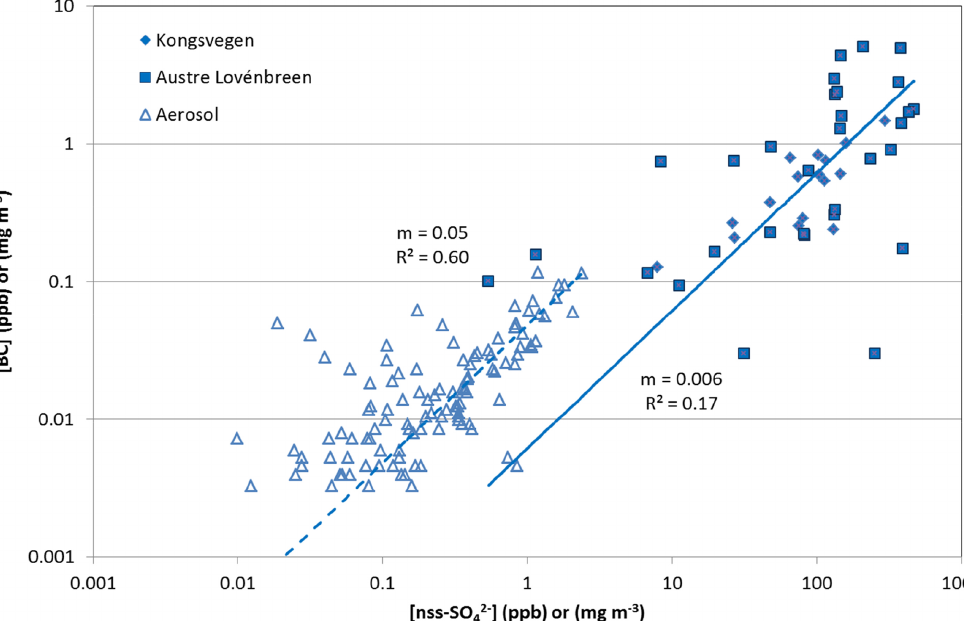
is almost 1 order of magnitude smaller than in the